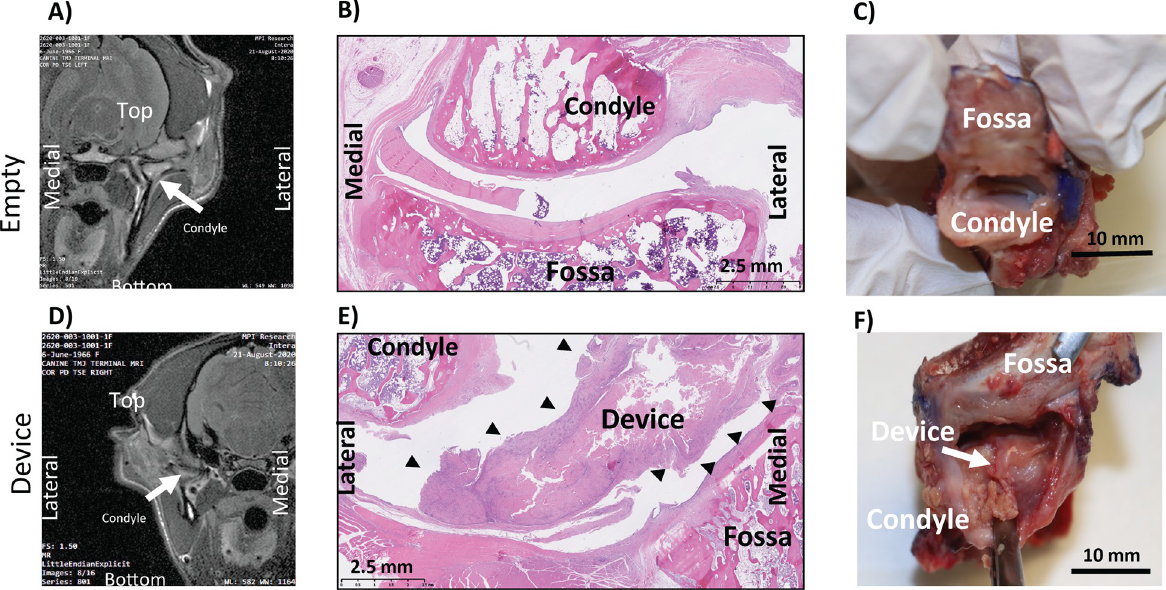
Fig 2. Animal 1001: Coronal MRI of empty (A) and implanted (D), Sagittal H&E of empty (B) and implanted (E), Necropsy Picture of empty (C) and implanted (F).